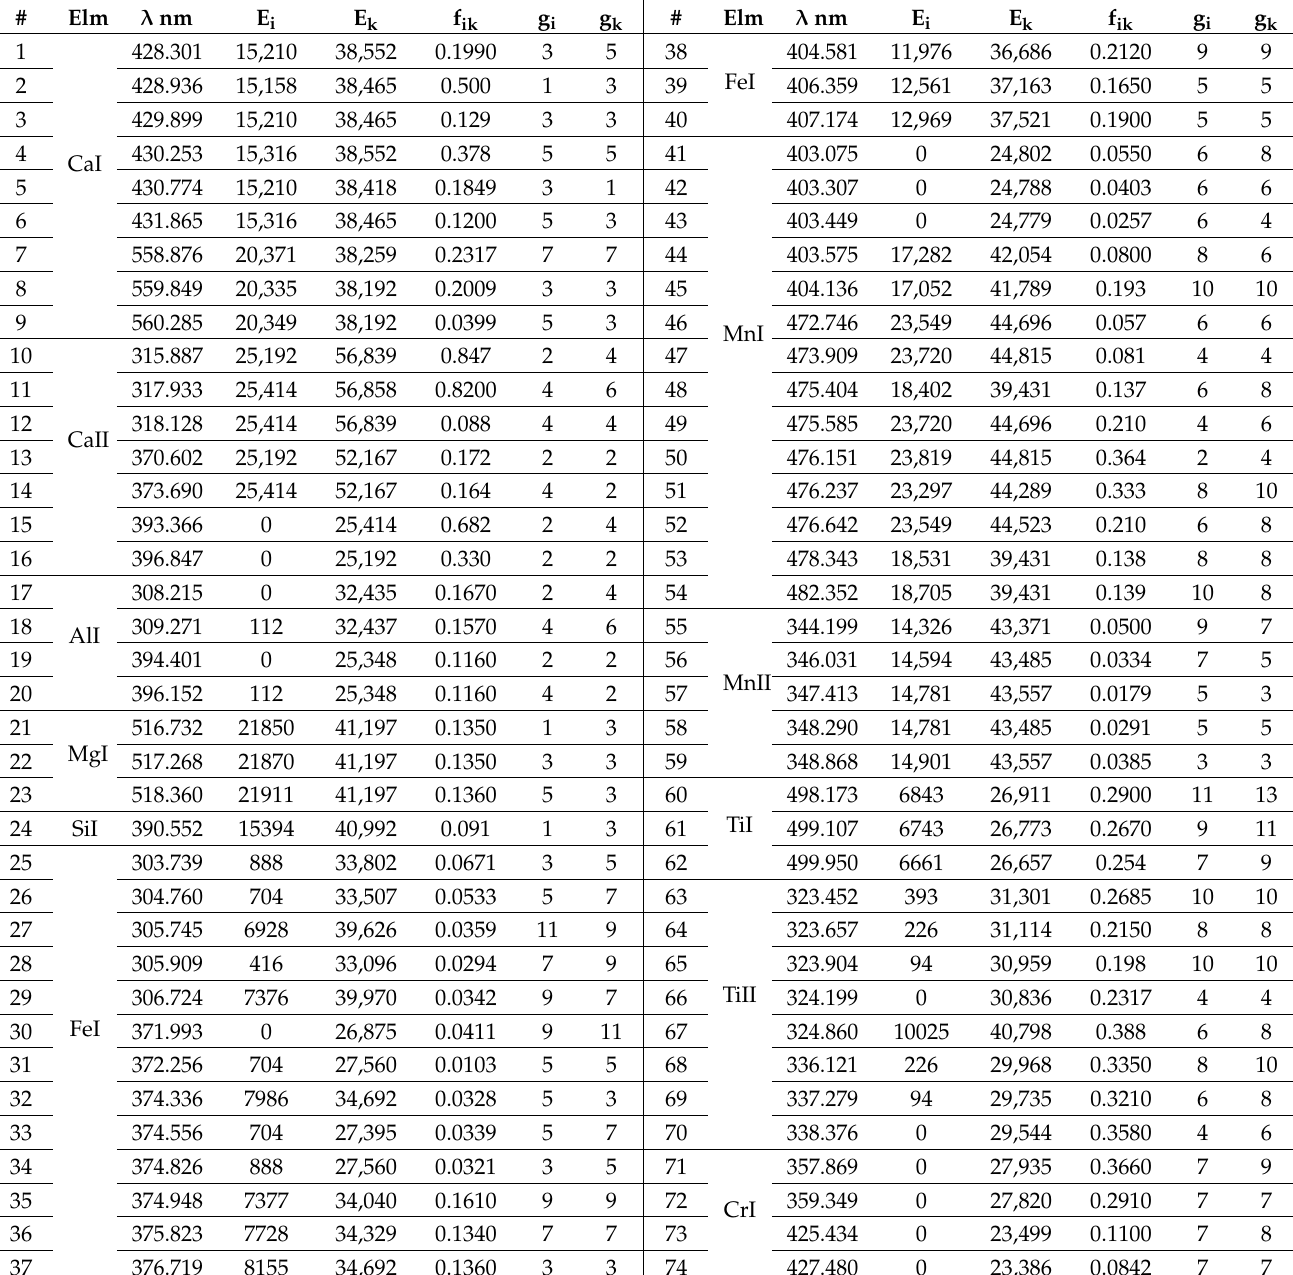
Table 2. Elements and spectral lines used to generate synthetic spectra.